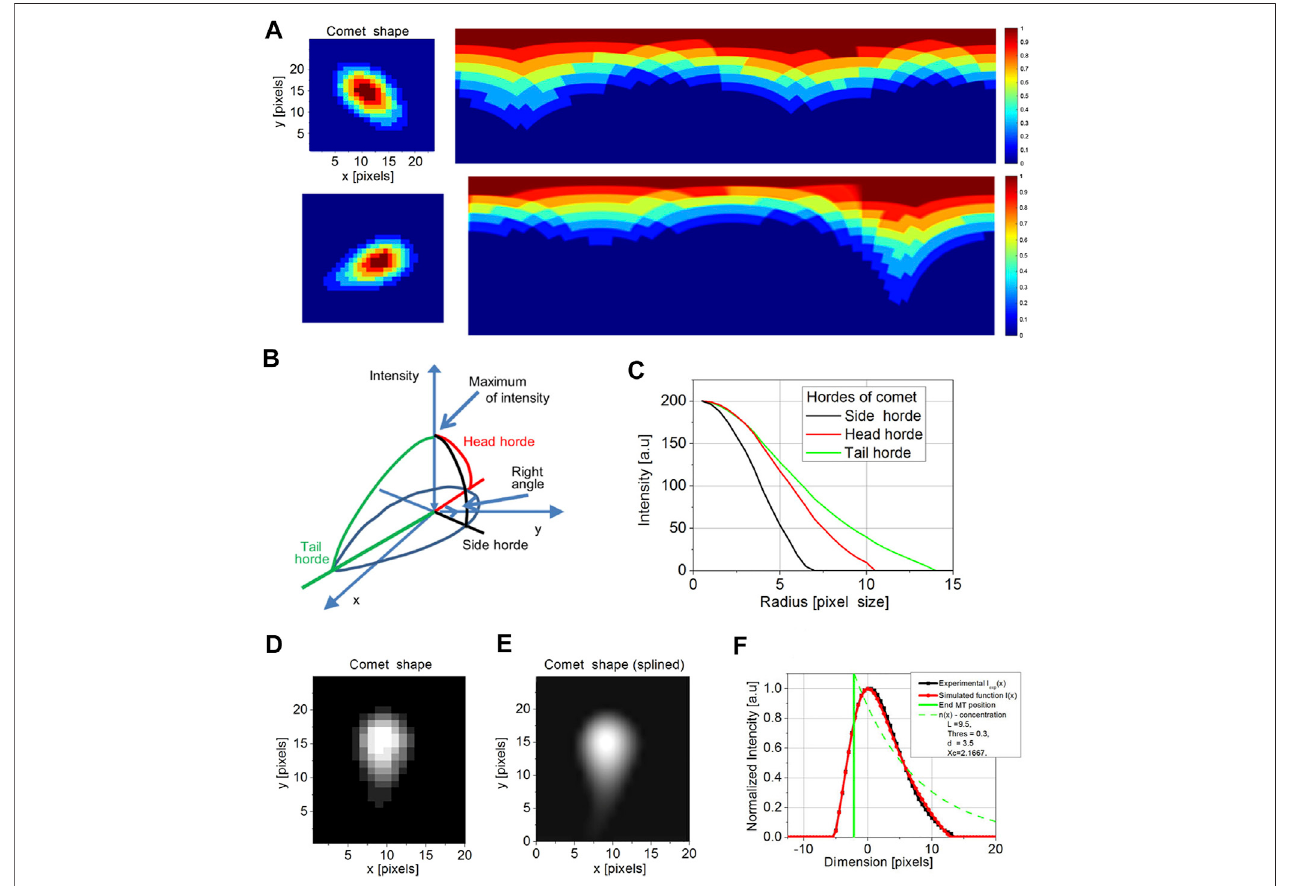
FIGURE 4 | Cartesian to polar transformation of a comet in a single time point for the comet with a short and long-tail (A) . The initial coordinates for transformation are set by maximum intensity pixel. The rainbow scale bar represents the intensity of each pixel. The model of comet intensities in XY and I (intensity) representation (B) was used to determine side (black) head (red) and tail (green) hordes. The model hordes of side (black), head (red), and tail (green) (C) were then compared with comet pro fi les. The original comet image is pixelized (D) . To compare it with a model, we perform a spline of comet images (E) . After determining the tail (red) and the real position of the tip of the microtubule (maximum in green), the comparison of exponential regression obtained by the current model (green), experimental pro fi le (black), and simulated pro fi le (red) was performed (F) . There is a signi fi cant shift between the MT end and an apparent maximum of intensity (set to 0).